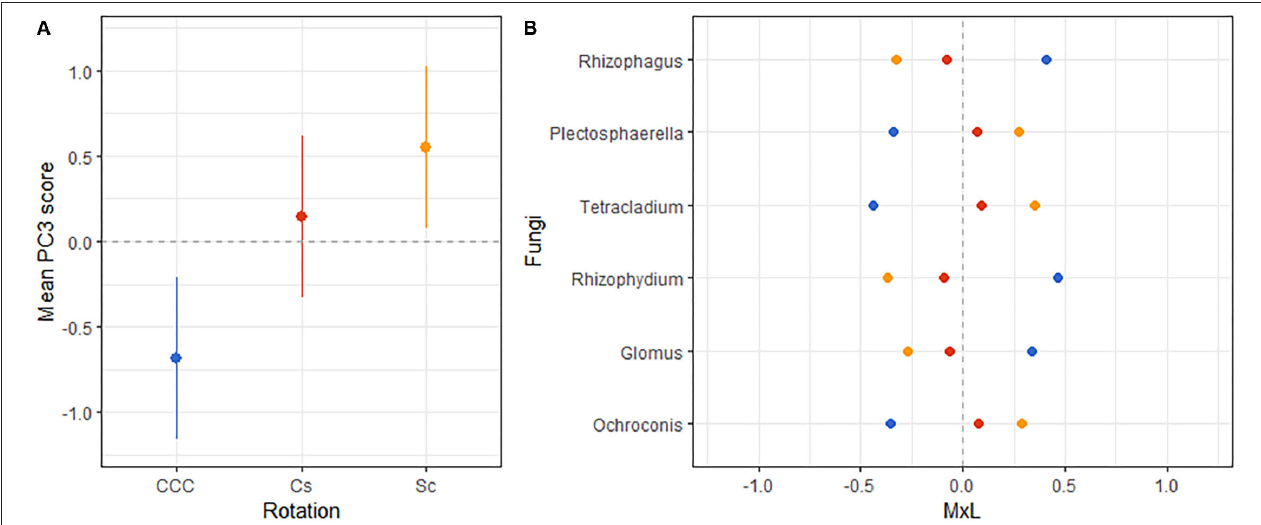
FIGURE 5 | (A) Mean value of the fungal PC3 for each rotation treatment with their standard errors (as whiskers). ( B) Contribution of each indicator fungi to the PC mean value (MxL) for each rotation treatment: continuous corn (blue), corn phase of the corn-soybean rotation (red), and soybean phase of the corn-soybean rotation (orange).